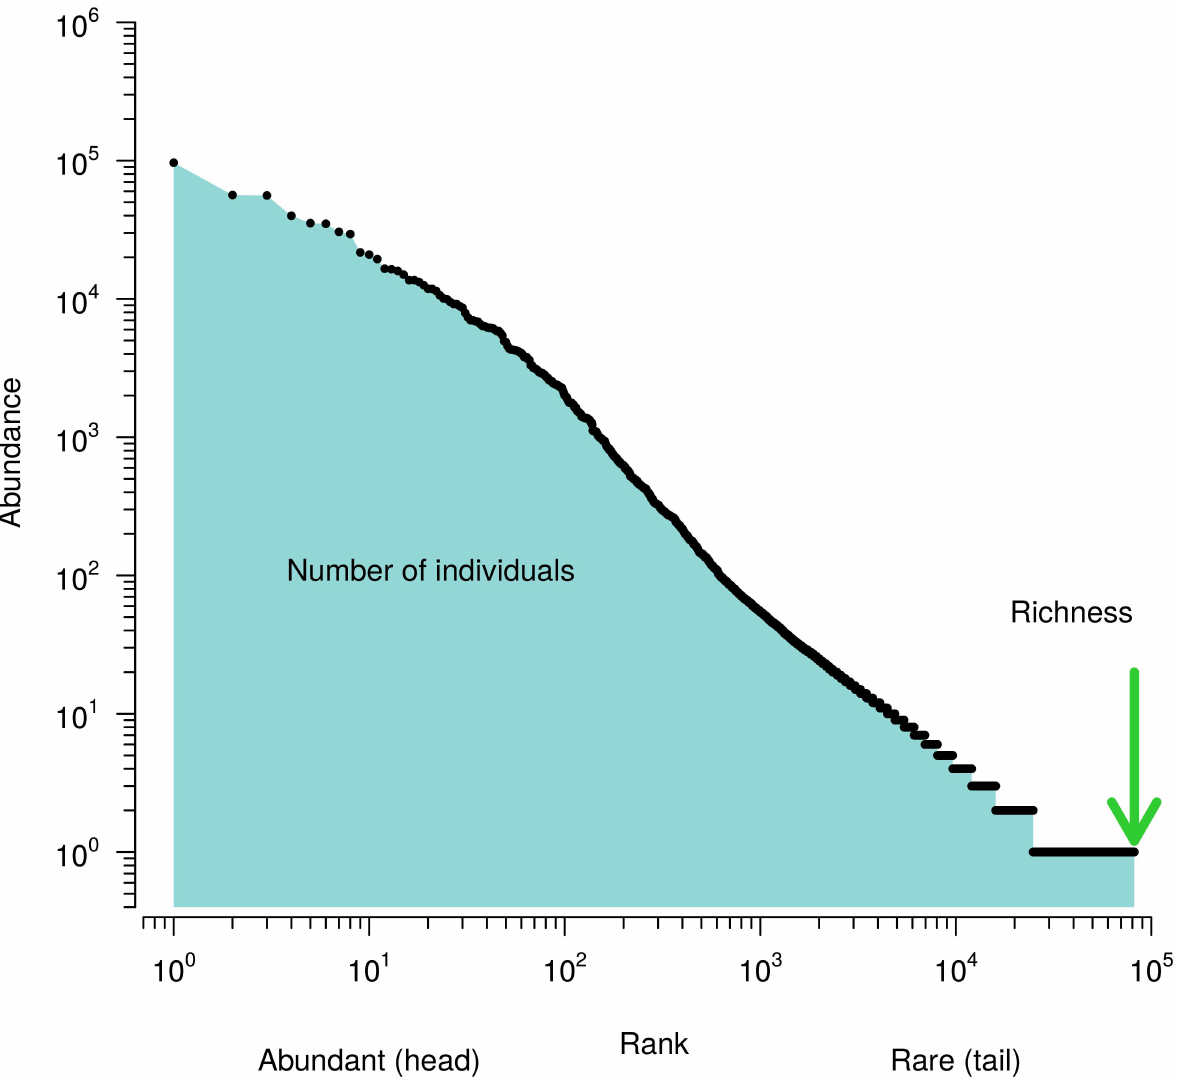
decreasing order, usually visualized as two dimensional plots, possibly with one or both axes scaled logarithmically. In comparison to the mentioned simple and binned histograms, RADs are more smooth due to their component sorting [7], and they retain the full biological resolu- tion of the sampling experiment. The information content in RADs and probability distribu- tion functions is the same, and one can be transformed into the other (see e.g. [8, 9]). Obviously, RADs retain the complete shape information of species-abundance tables. The abstraction of species information means that RADs enable analysis of generic abundance dis- tribution features of generalized communities, independently of the actual species